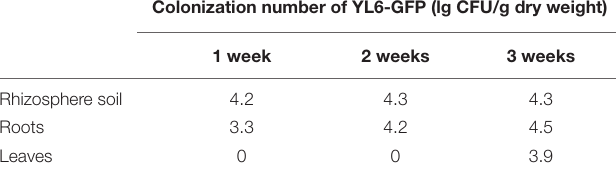
TABLE 4 | Colonization dynamics of YL6-GFP in leaves, roots and rhizosphere soil of Chinese